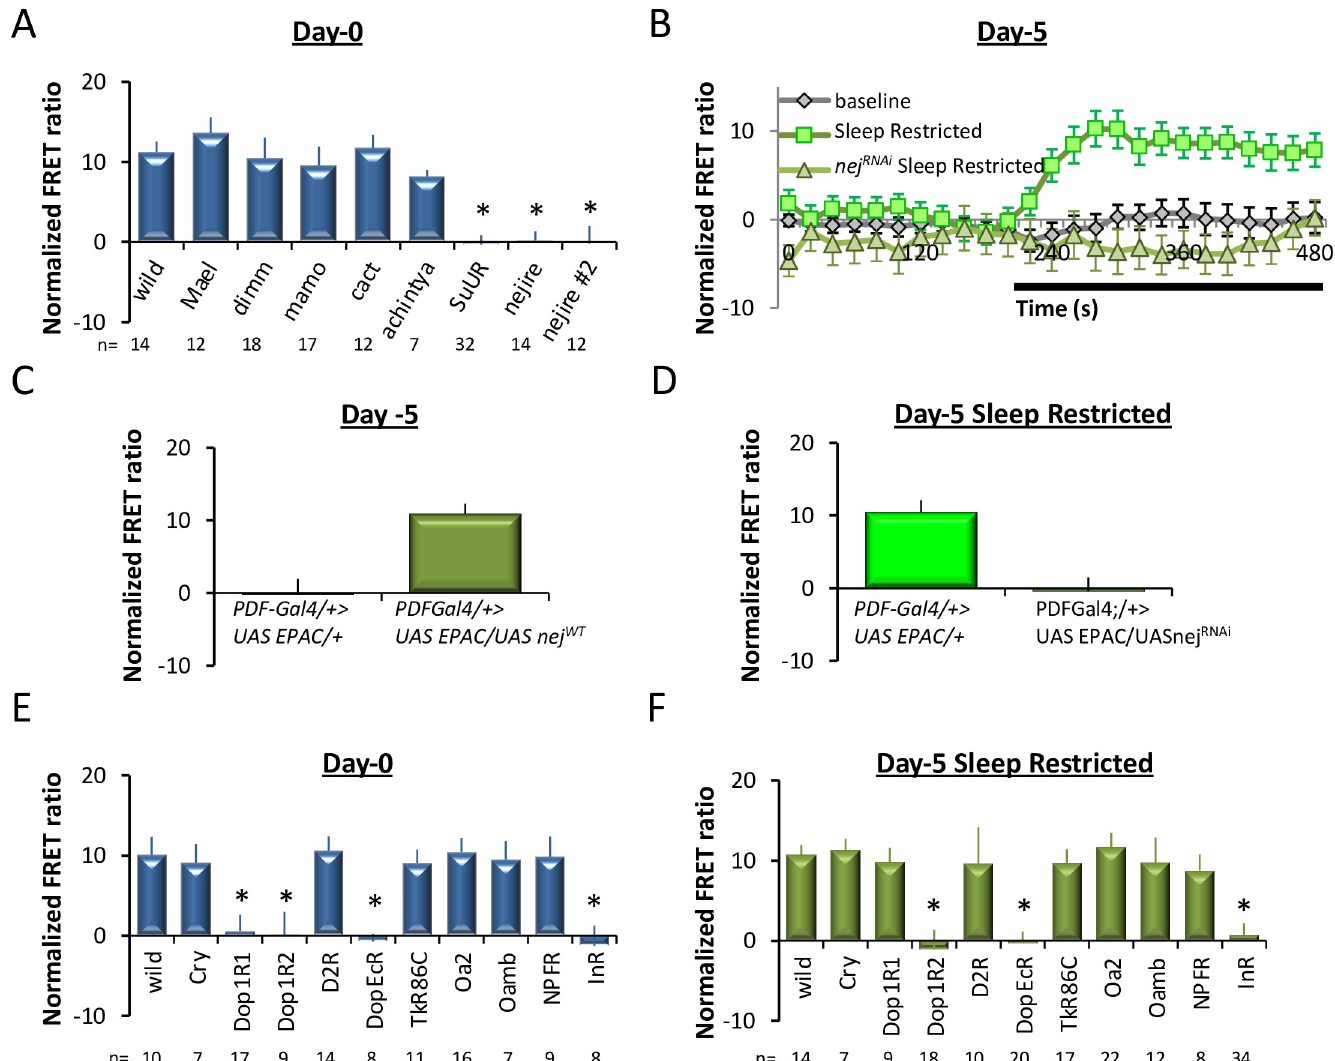
Fig 6. nejire regulates PDFR respecification in l-LNvs of both young and mature flies. (A) The amplitude of l-LNv responses to PDF on day 0 in Pdf-GAL4 > UAS- Epac1 flies crossed to UAS - RNAi lines of the depicted transcription factors (ANOVA; F [8,127] = 11.1, p = 1.26 E-11 , � p < 0.05, modified Bonferroni test, n are listed below the x-axis). (B) PDF amplitude in control and 5-day-old sleep restricted Pdf-GAL4 > UAS - Epac1 flies compared to Pdf-GAL4 > UAS - Epac1 flies expressing UAS-nej RNAi ( n = 6–19 neurons/genotype). (C) In the absence of sleep loss, the l-LNvs of Pdf-GAL4 > UAS - Epac1 / UAS-nej WT respond to PDF while age-matched Pdf-GAL4 > UAS - Epac1 do not ( t test, DF 34–1, t = 22.6, p = 3.74 e-5 , n = 9–26 neurons/genotype). (D) Data quantified from (B). ( t test, DF 40–1, t = 17.8, p = 4.10 e-4 , n = 16–26). (E) The amplitude of l-LNv responses to PDF in l-LNvs on day 0 in Pdf-GAL4 > UAS - Epac1 flies crossed to UAS-RNAi lines of the depicted cell surface receptors (ANOVA F [10,105] = 5.38, p = 2.8 − 6 p < 0.05, modified Bonferroni test, n are listed below the x-axis). (F) The amplitude of l-LNv responses to PDF in l-LNvs on day 5 in sleep- restricted Pdf-GAL4 > UAS - Epac1 flies crossed to UAS-RNAi lines of the depicted cell surface receptors (ANOVA F [10,179] = 7.04, p = 3.3 E-9 p < 0.05, modified Bonferroni test, n are listed below the x-axis). Data underlying this figure can be found in S6 Data. FRET AU : PleasedefineFRETinFig 6 abbreviationlistifthisindeedisanabbreviation : , Fo¨rster Resonance Energy Transfer; l-LNv, large ventral lateral neuron; PDF, pigment dispersing factor; PDFR, pigment dispersing factor receptor.